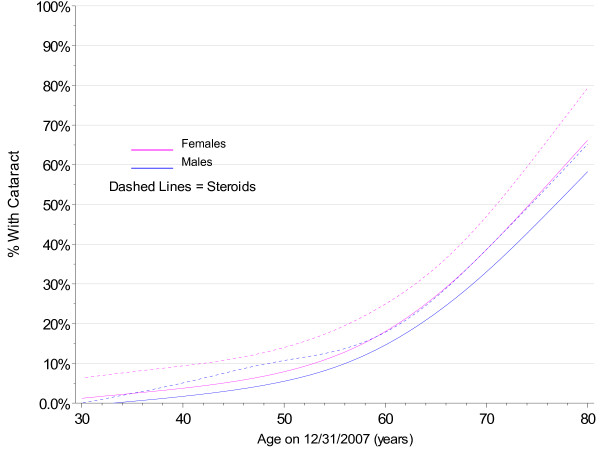
Smoothed 2007 Prevalence of Cataract by Gender and Steroid Use Cohort with No Diabetes.